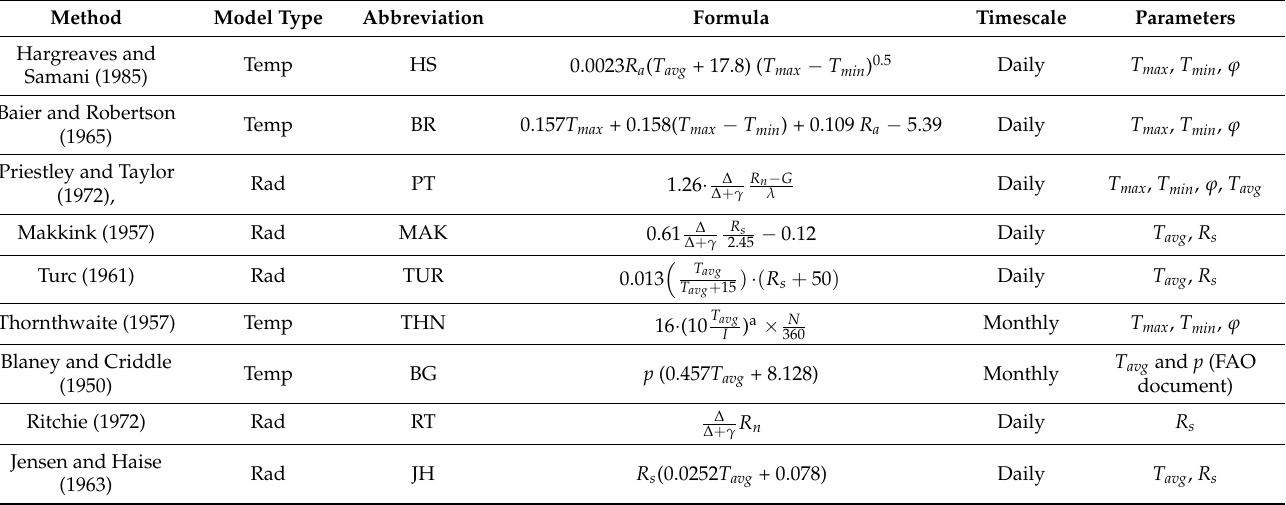
Table 1. Selected ETo empirical estimation methods which are compared with against the FAO56–PM method with their equation, reference, and other